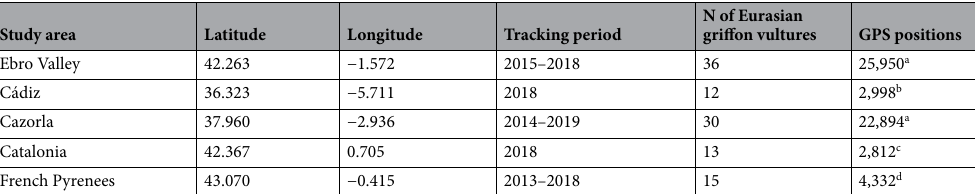
Table 1. Locations, sample sizes and characteristics of the different study populations. Central position of the study populations; tracking periods, number of Eurasian griffon vultures tracked and number of GPS positions analyzed (one position/day/individual). All the individuals were resident adults. a Solar-powered GPS/GPRS- GSM (e-obs) (90 g). https://e- obs. de/. b Solar-powered GPS-GSM Backpack series Griffon LF (Ecotone) (34